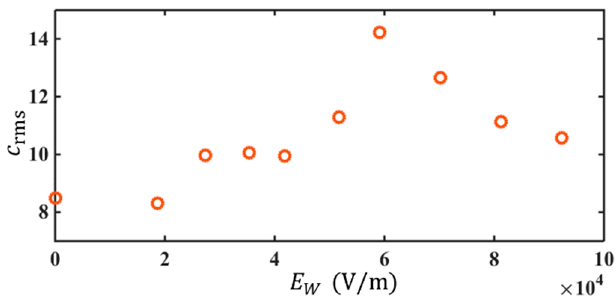
Figure 8. 𝑐 (cid:3045)(cid:3040)(cid:3046) vs. 𝐸 (cid:3050) at 𝑄 = 3 µL/min and 𝑓 (cid:3033) = 130 kHz. Figure 8. c rms vs. E w at Q = 3 µ L/min and f f = 130 kHz.